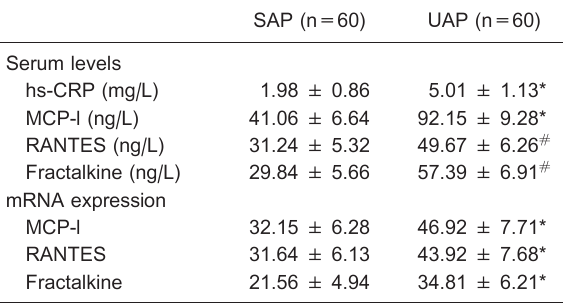
Table 3. Serum high-sensitivity C-reactive protein (hs-CRP) and chemokine levels and chemokine mRNA expression in the stable (SAP) and unstable (UAP) angina pectoris groups of patients.